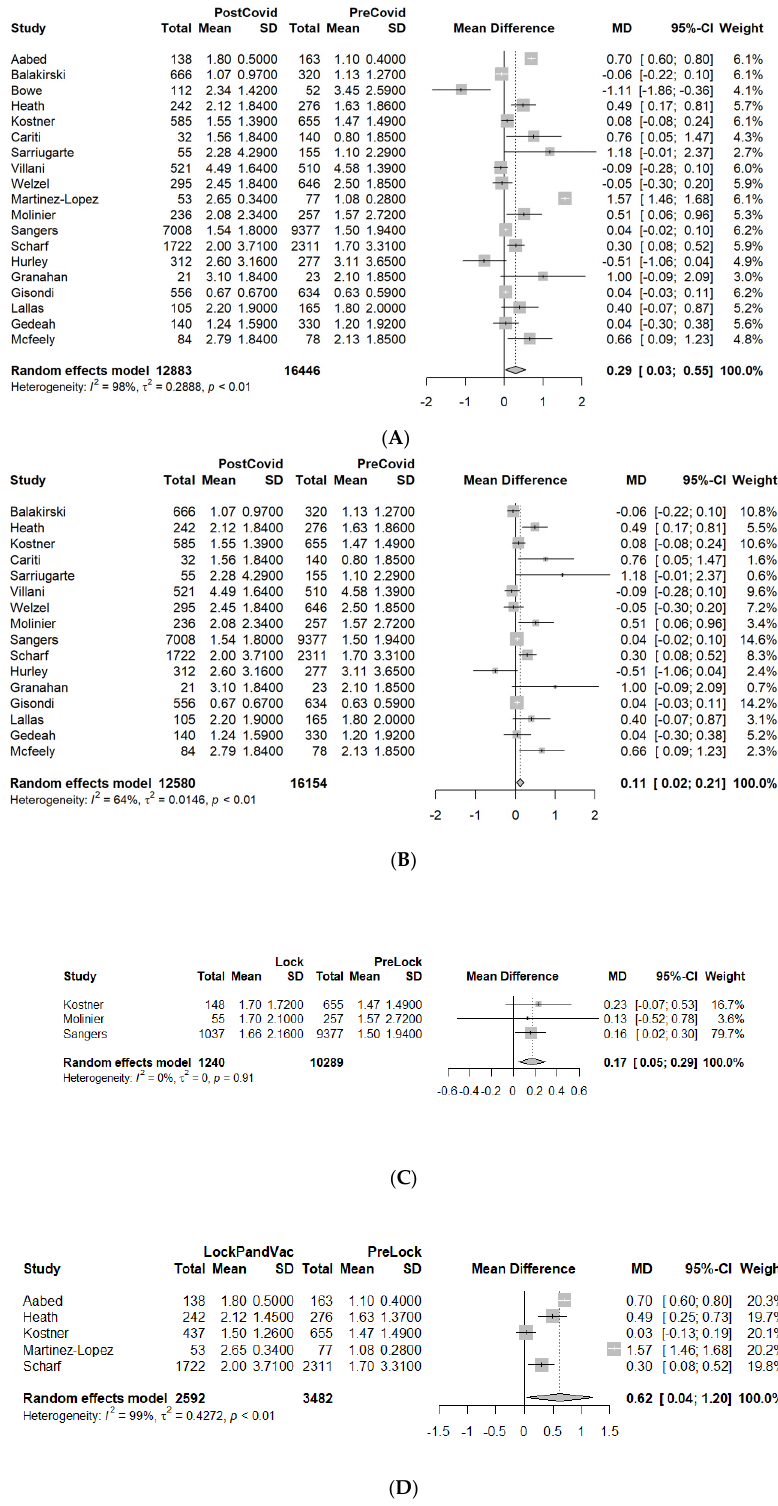
Figure 2. ( A ). Forest plot of Breslow thickness results for the PreCovid and PostCovid groups. ( B ). Forest plot of the Breslow thickness sensitivity analysis results for the PreCovid and PostCovid groups. ( C ). Forest plot of Breslow thickness results for the PreLock and Lock groups. ( D ). Forest plot of Breslow thickness results for the PreLock and LockPandVac groups.